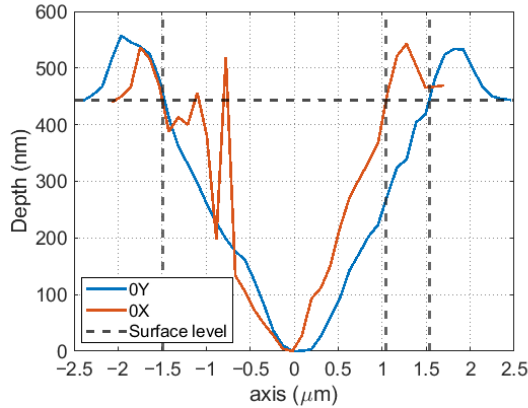
Figure 3. Cross-sections of the AFM depth profile along the 0X and 0Y axes.